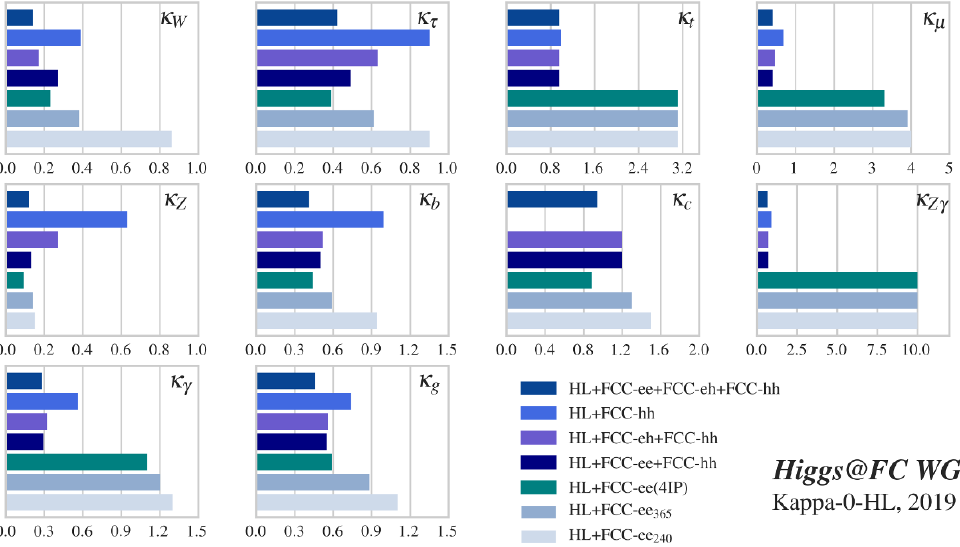
Figure 15 . Comparison of the di(cid:11)erent FCC scenarios in the kappa-0-HL scenario (similar to kappa-0 in that it does not allow any BSM decay, but including HL-LHC data).